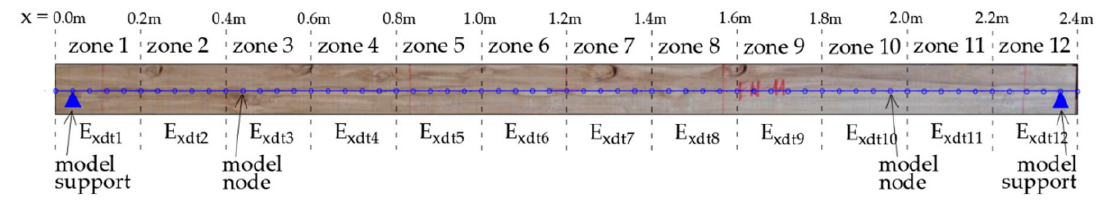
Figure 7. Numerical model of timber